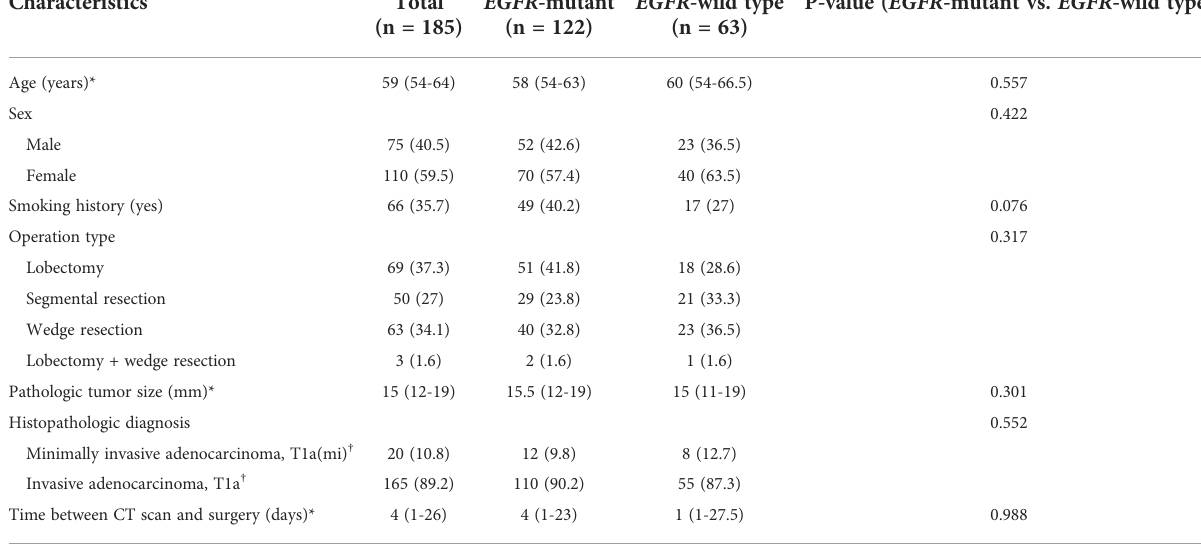
TABLE 1 Demographic information and tumor characteristics of the primary cohort (n =